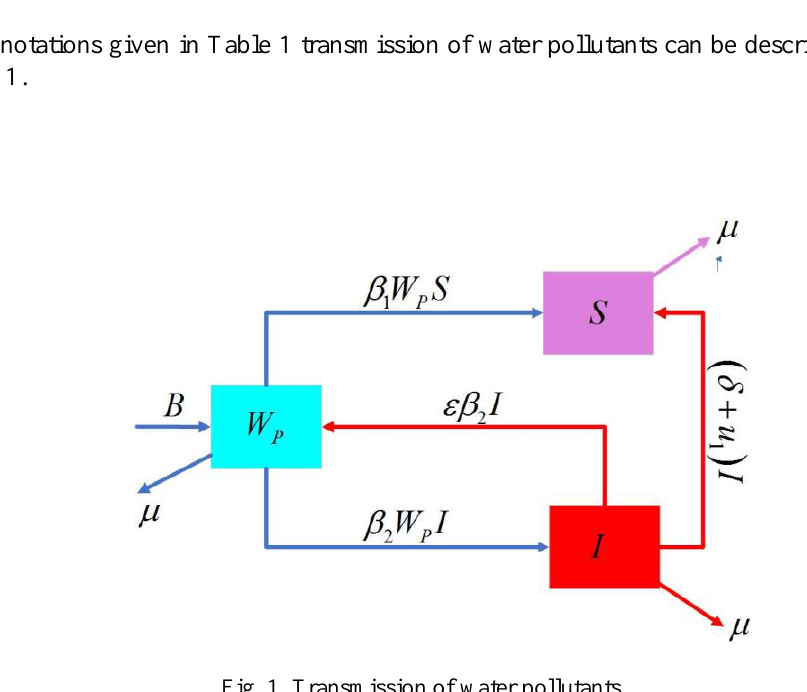
Fig. 1. Transmission of water